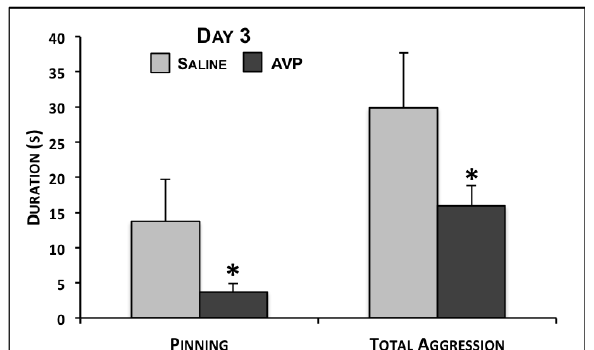
Figure 3. Mean + SEM duration values for pinning and total aggression (sum of attacks, pinning, kicking and biting) on day 3 of lactation during a 30 min maternal aggression observation test of chronic social stressed dams treated with either saline or AVP. * indicates a significant difference between treatments ( p <